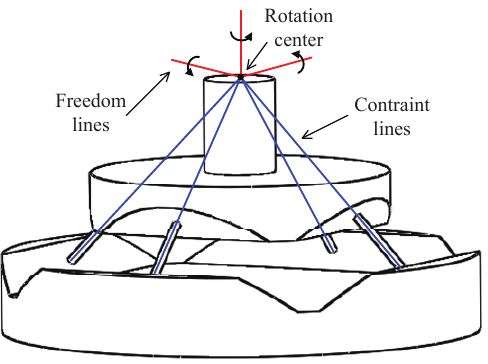
Figure 3. Diagnosis of the RCC mechanism using the Freedom and constraint topology (FACT)